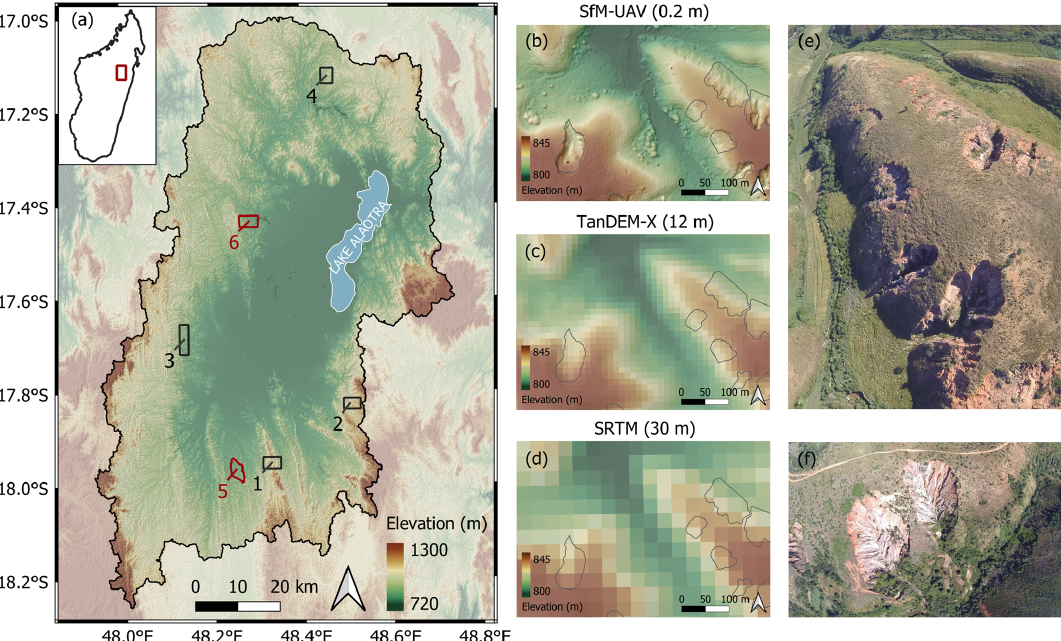
Figure 1. Study areas, examples of each digital elevation model (DEM), and lavaka examples. (a) Six study areas of ca. 10km 2 in the Lake Alaotra catchment shown on the TanDEM-X DEM with hillshade. The UAV-SfM DEM is available for study area 5 and 6 (red) (data collected June 2018). (b–d) Examples of the Copernicus (AIRBUS, 2020a), TanDEM-X (Krieger et al., 2007), and UAV-SfM DEM (data collected June 2018) in SA6 located at 17 ◦ 58 (cid:48) 51.7 (cid:48)(cid:48) S, 48 ◦ 15 (cid:48) 18.6 (cid:48)(cid:48) E with hillshade. Grey outlines indicate the digitized lavaka. (e) UAV fisheye picture from 200m height of the eastern ridge shown in (b–d) . (f) UAV fisheye picture (200m height) from two typical amphitheater-shaped lavaka (pictures taken in June 2018 by Liesa